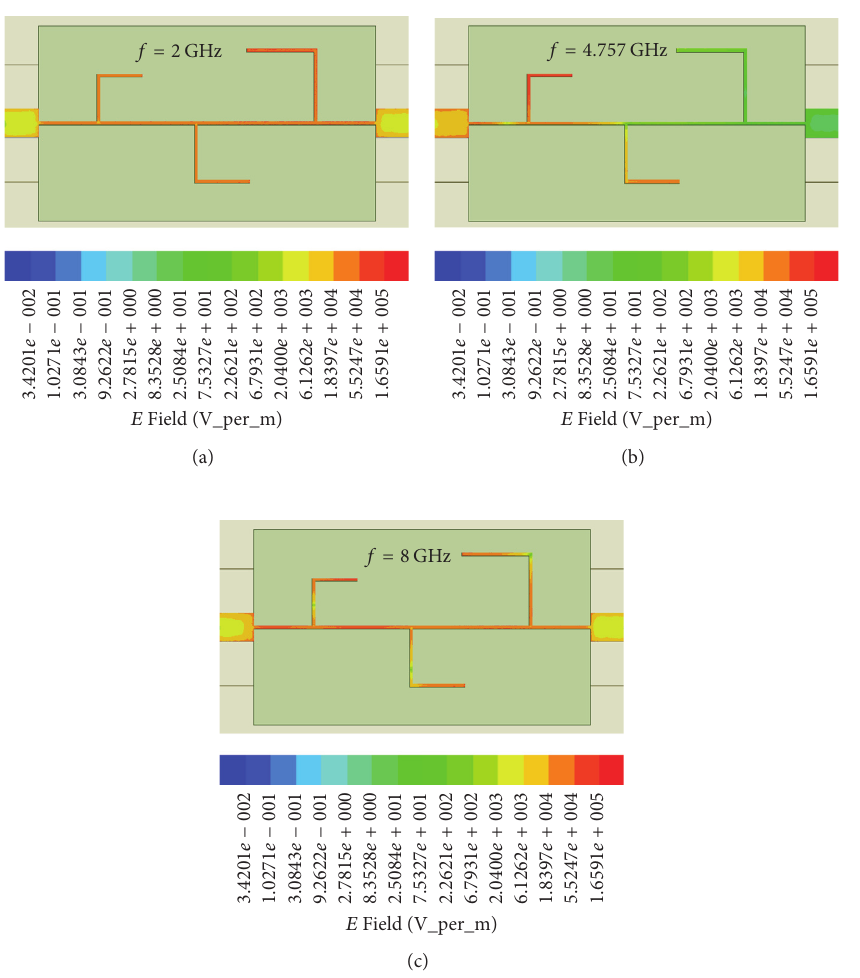
Figure 7: Electric field distributions of the proposed filter in the untuned state at its (a) passband 2 GHz, (b) stopband 4.757 GHz, and (c) passband 8 GHz.